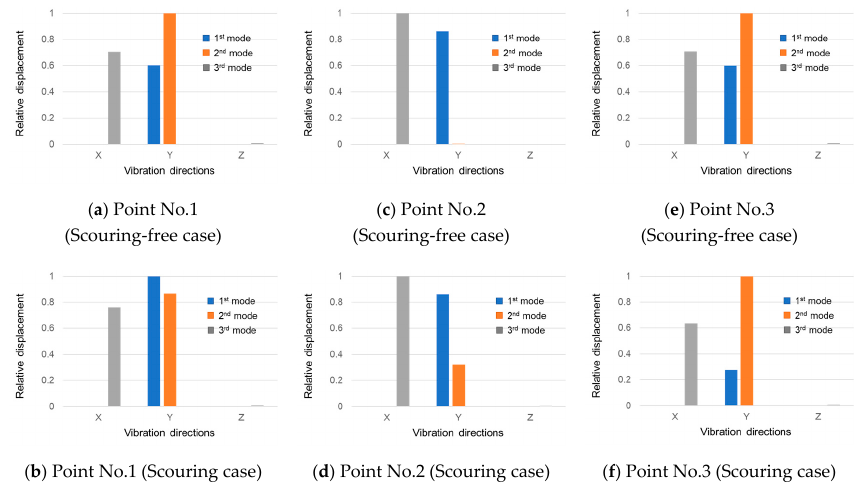
Figure 10. Relative amplitude in mode shapes at observation points for scouring-free and scouring cases.